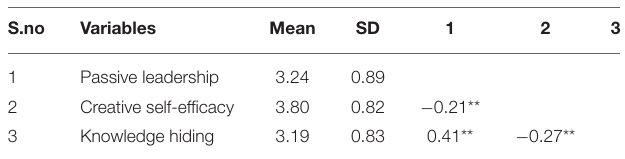
TABLE 4 | Correlation.